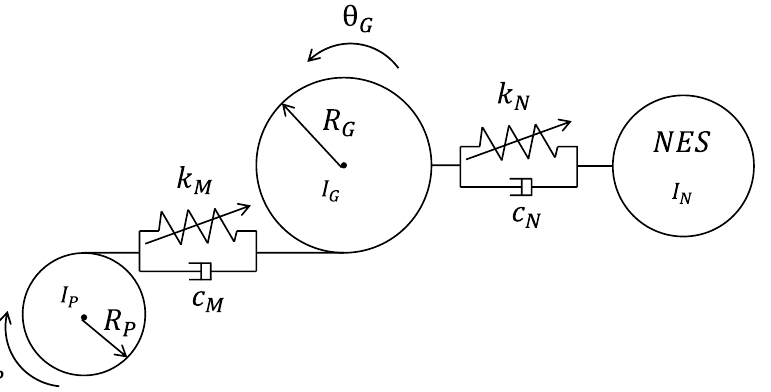
Figure 1. Sketch of the general layout of a gear pair equipped with an NES; 𝐼 𝑃 represents the pinion, 𝐼 𝐺 represents the gear; 𝐼 𝑁 represents the NES; 𝑘 𝑀 denotes the gear pair meshing stiffness and 𝑘 𝑁 the stiffness of the NES attachment.